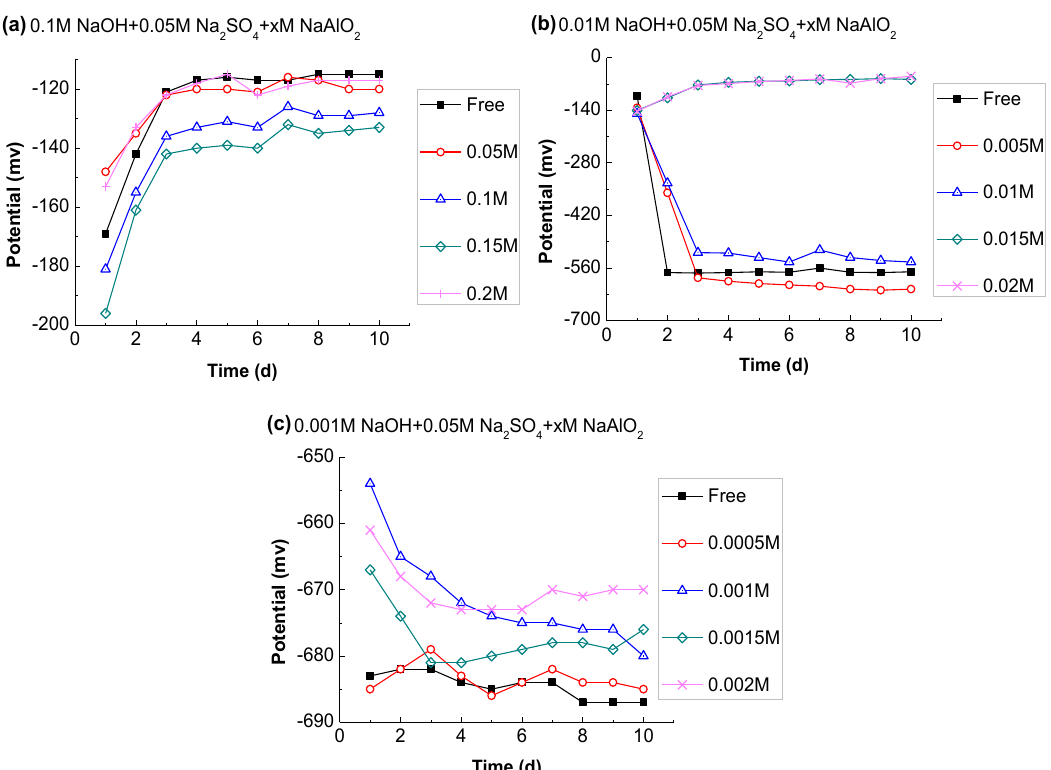
Figure 6. Effect of Al(OH) − concentrations on the OCP. ( a ) 0.1 M NaOH + 0.05M Na 2 SO 4 + 𝓍 M NaAlO 2 ; ( b ) 0.01 M NaOH + 0.05M Na 2 SO 4 + 𝓍 M NaAlO 2 ; ( c ) 0.001 M NaOH + 0.05M Na 2 SO 4 + 𝓍 M NaAlO 2 .